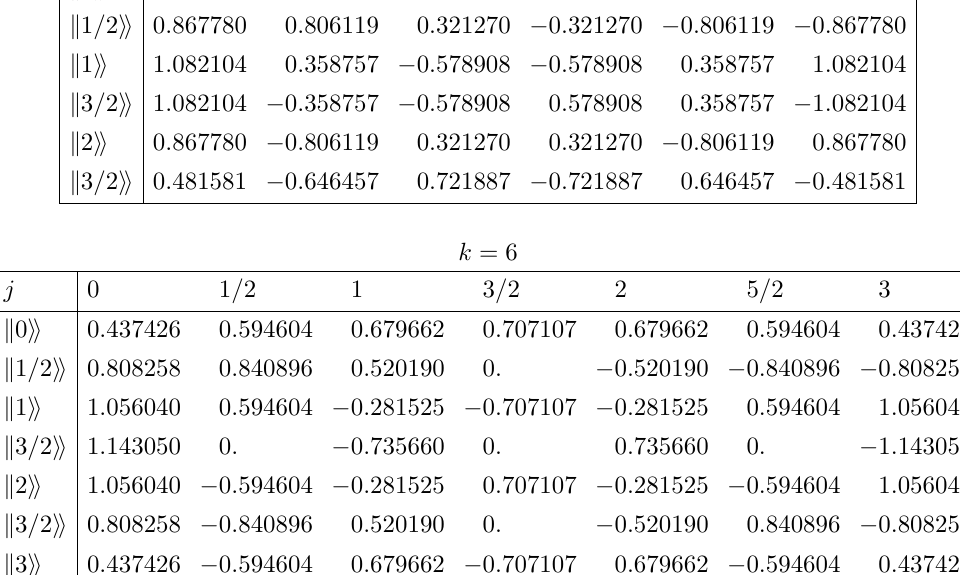
Table 1 . Numerical values of components B j